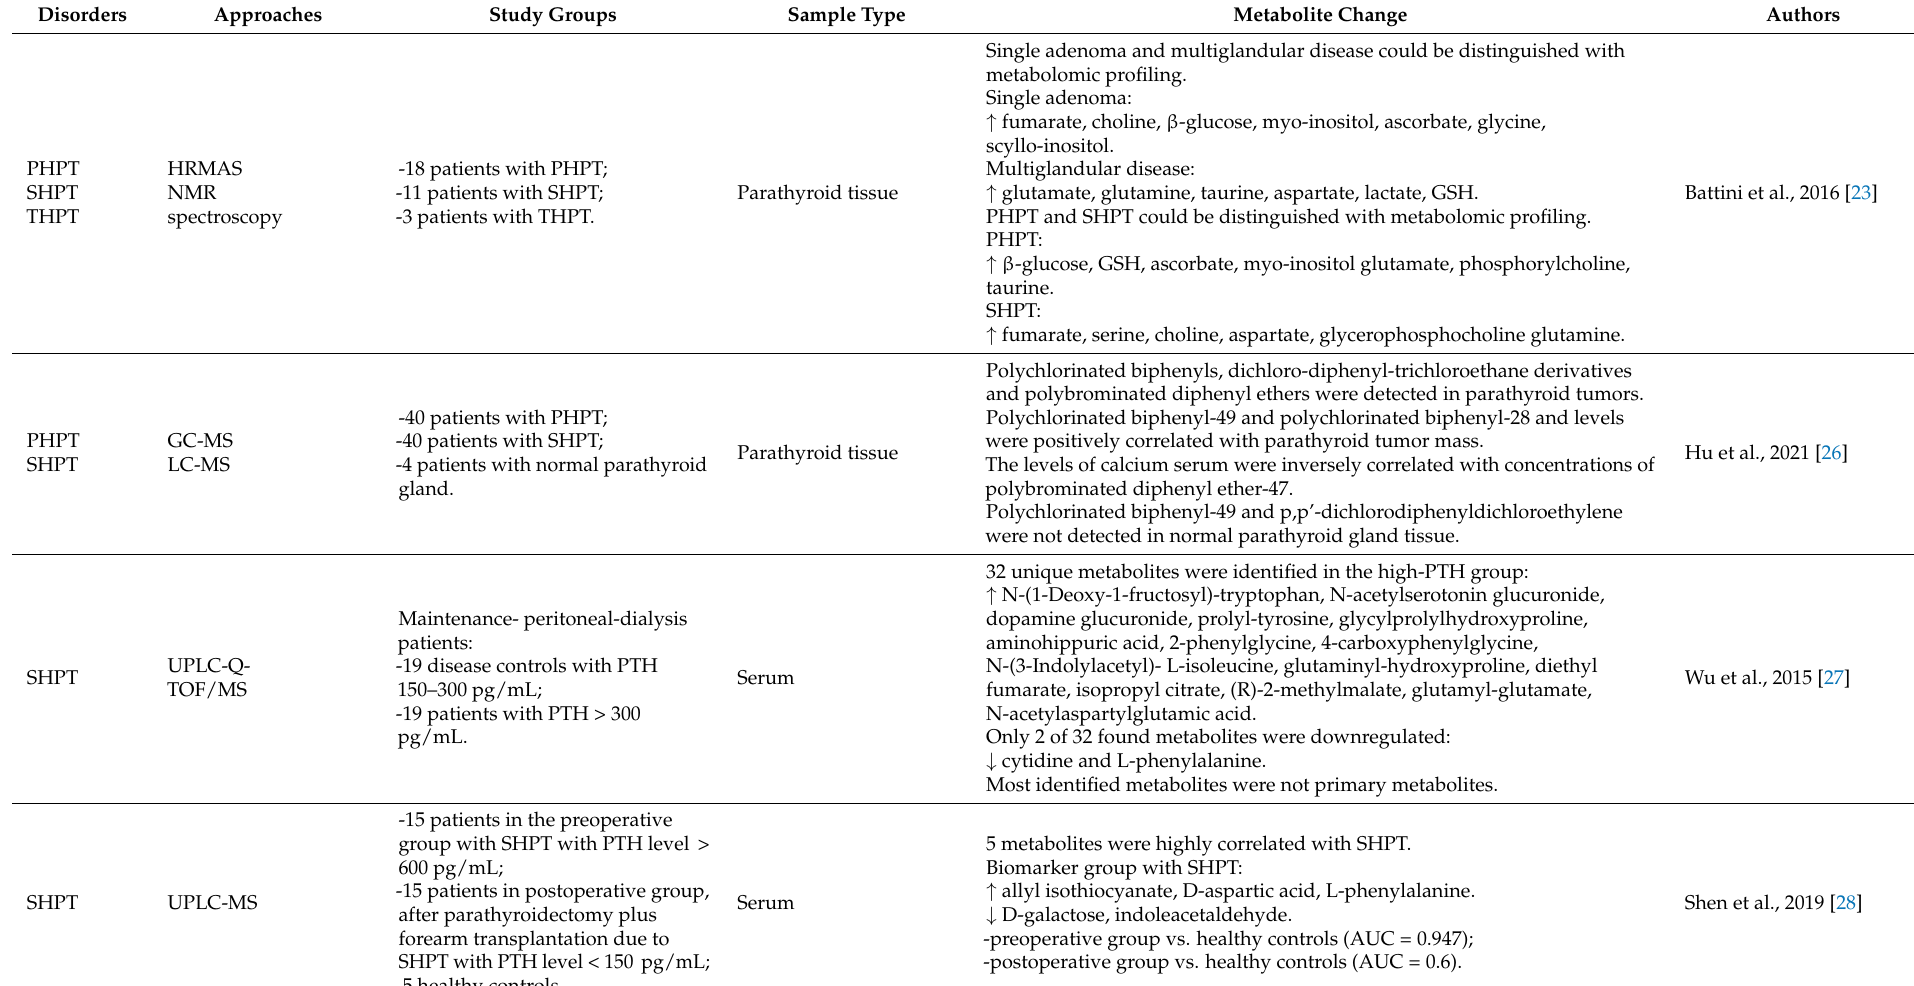
Table 1. Biomarkers and related metabolic pathways in human calcium metabolic disorders discovered using metabolomics